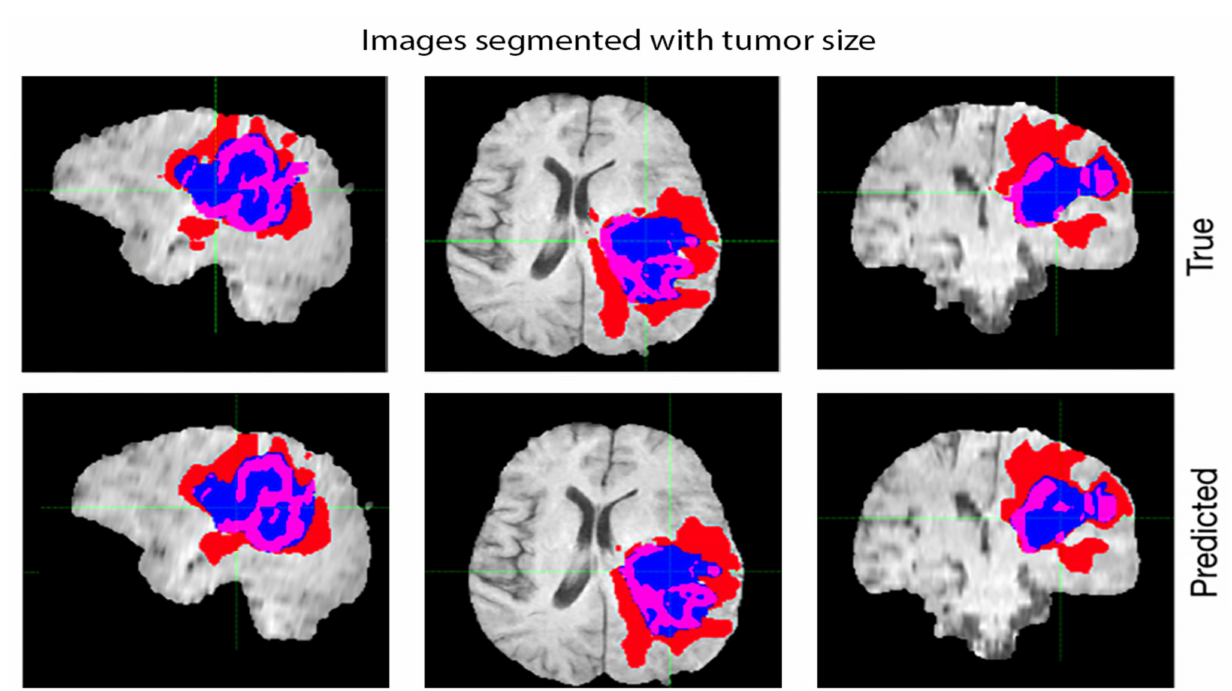
Figure 7. Segmentation of Brain Tumors using MRI Scans: A Comparative Analysis of Three Image Processing